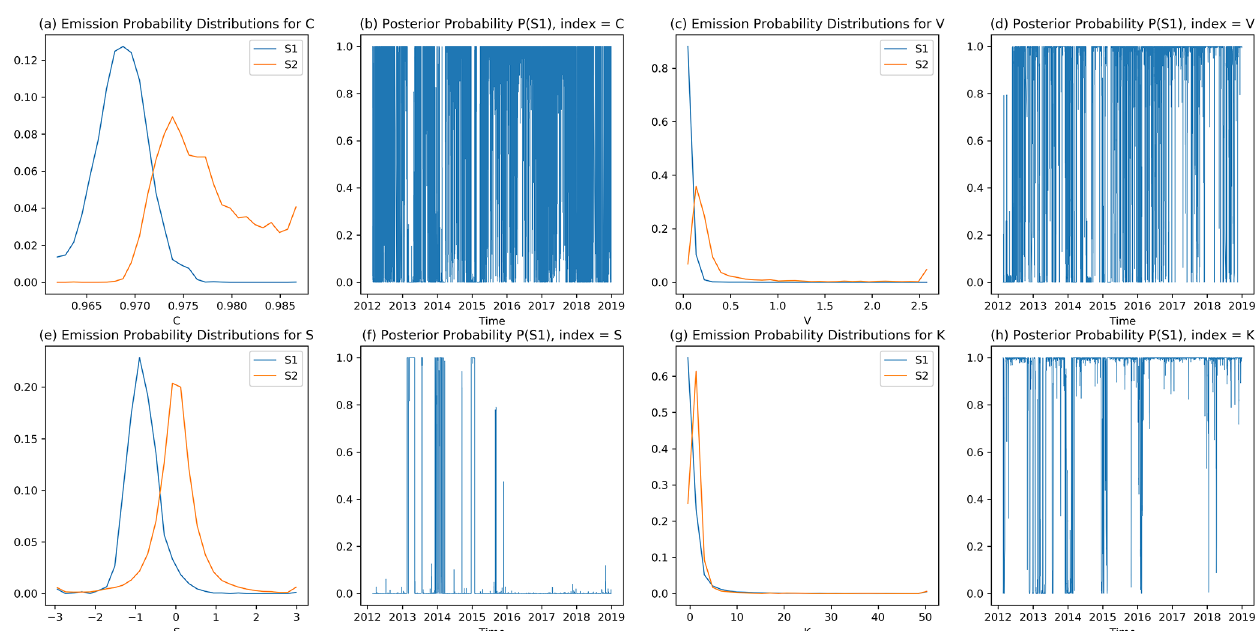
Figure 3. The output of BWA: the emission probability or the probability mass functions, as well as their posterior HS probability TSs, for C NS ,t (a, b) , V NS ,t (c, d) , S NS ,t (e, f) , and K NS ,t (g, h) , using KAOH’s geoelectric TS data with 50